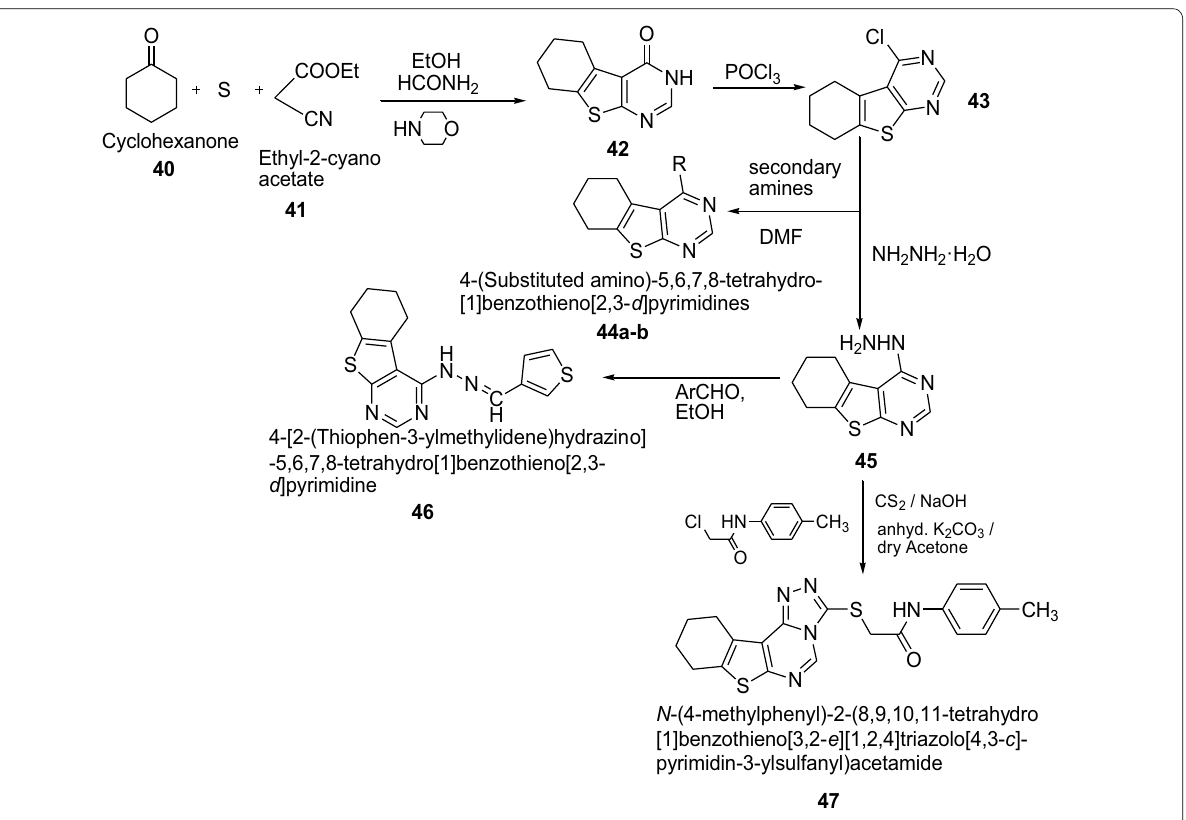
Table 10 Antibacterial and antifungal activities of synthesized compounds Compound The inhibition zones (IZ) in mm